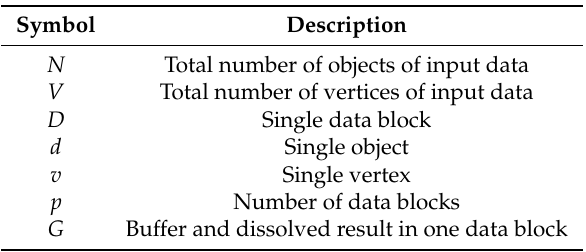
Table 1. Symbols used in this